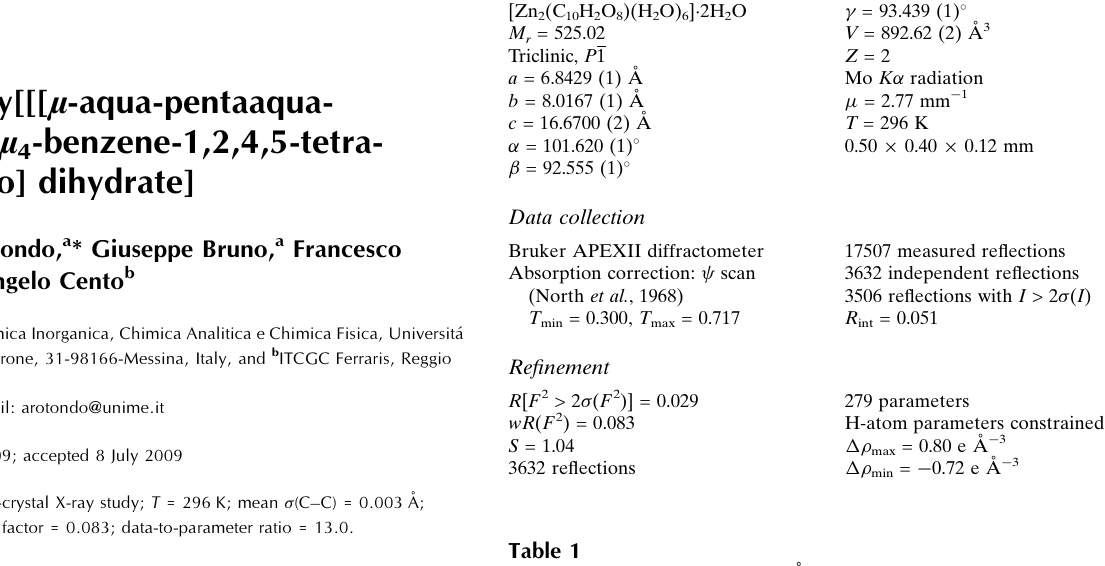
Selected geometric parameters (A˚ , (cid:3) ).